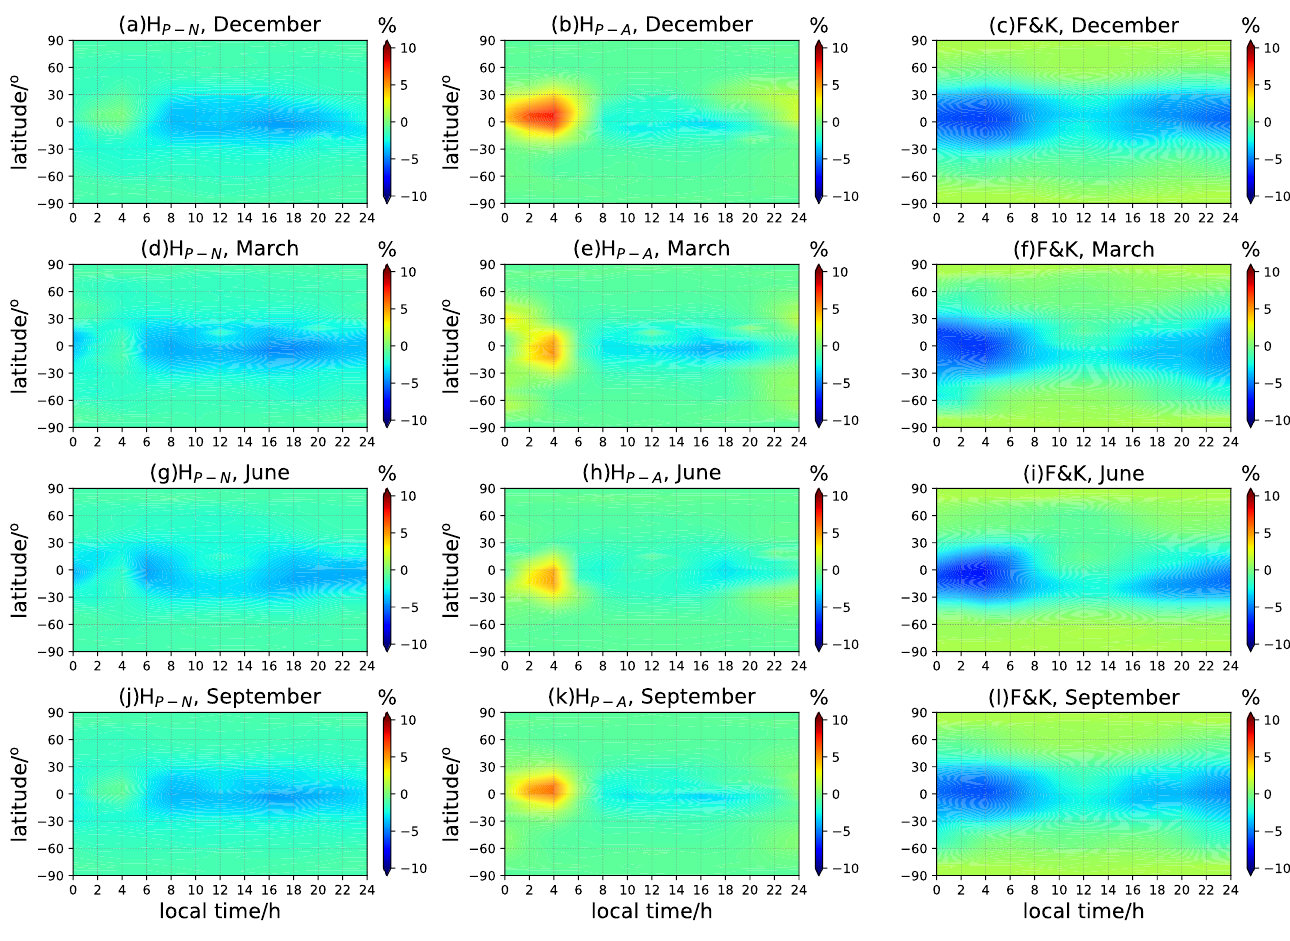
Figure 7. Same as Figure 6 but for HSA year.